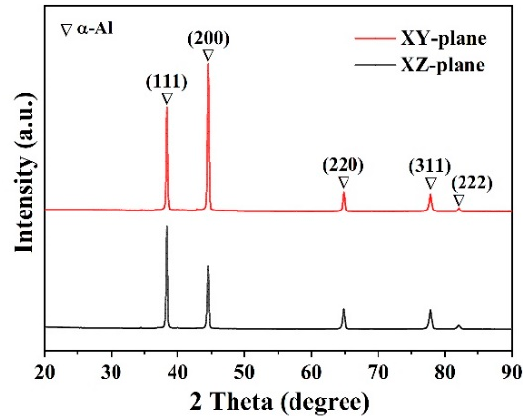
Figure 7. XRD patterns of as-built sample for different planes.